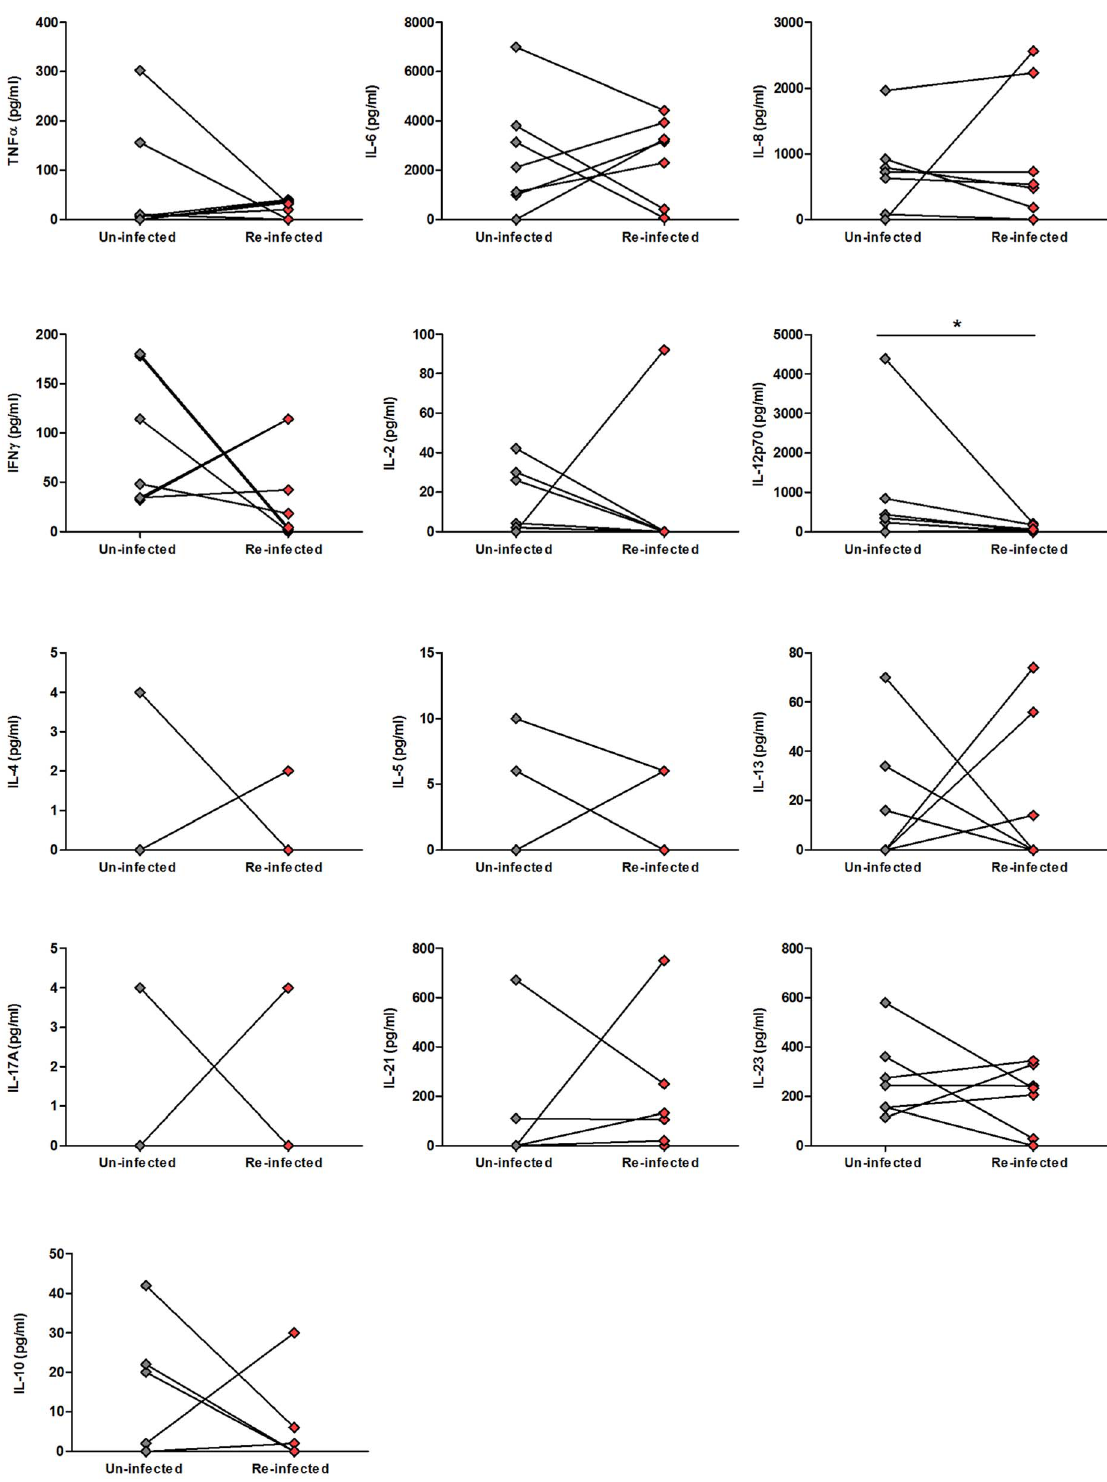
Figure 5. Levels of 6 weeks post-treatment GST-specific cytokines in children who remained un-infected and those who were re- infected within 18 months of treatment. The levels GST-specific (pg/ml, untransformed) cytokines associated with innate inflammatory ( top row ), Th1 ( second row ), Th2 ( third row ), Th17 ( fourth row ) and regulatory ( fifth row ) responses produced 6 weeks after treatment by un- infected children ( grey diamonds ) and age, gender and pre-treatment infection intensity-matched children who were re-infected ( red diamonds ) within 18 months of treatment (i.e. $ 1 S. haematobium egg in any of their urine samples collected 6 months and 18 months post-treatment). Lines join age, sex and infection intensity matched pairs and details of the characteristics of each pair are provided in Table S3 . Results of paired Wilcoxon comparison between un-infected (n=7) and re-infected children (n=7) are indicated, *p , 0.05.